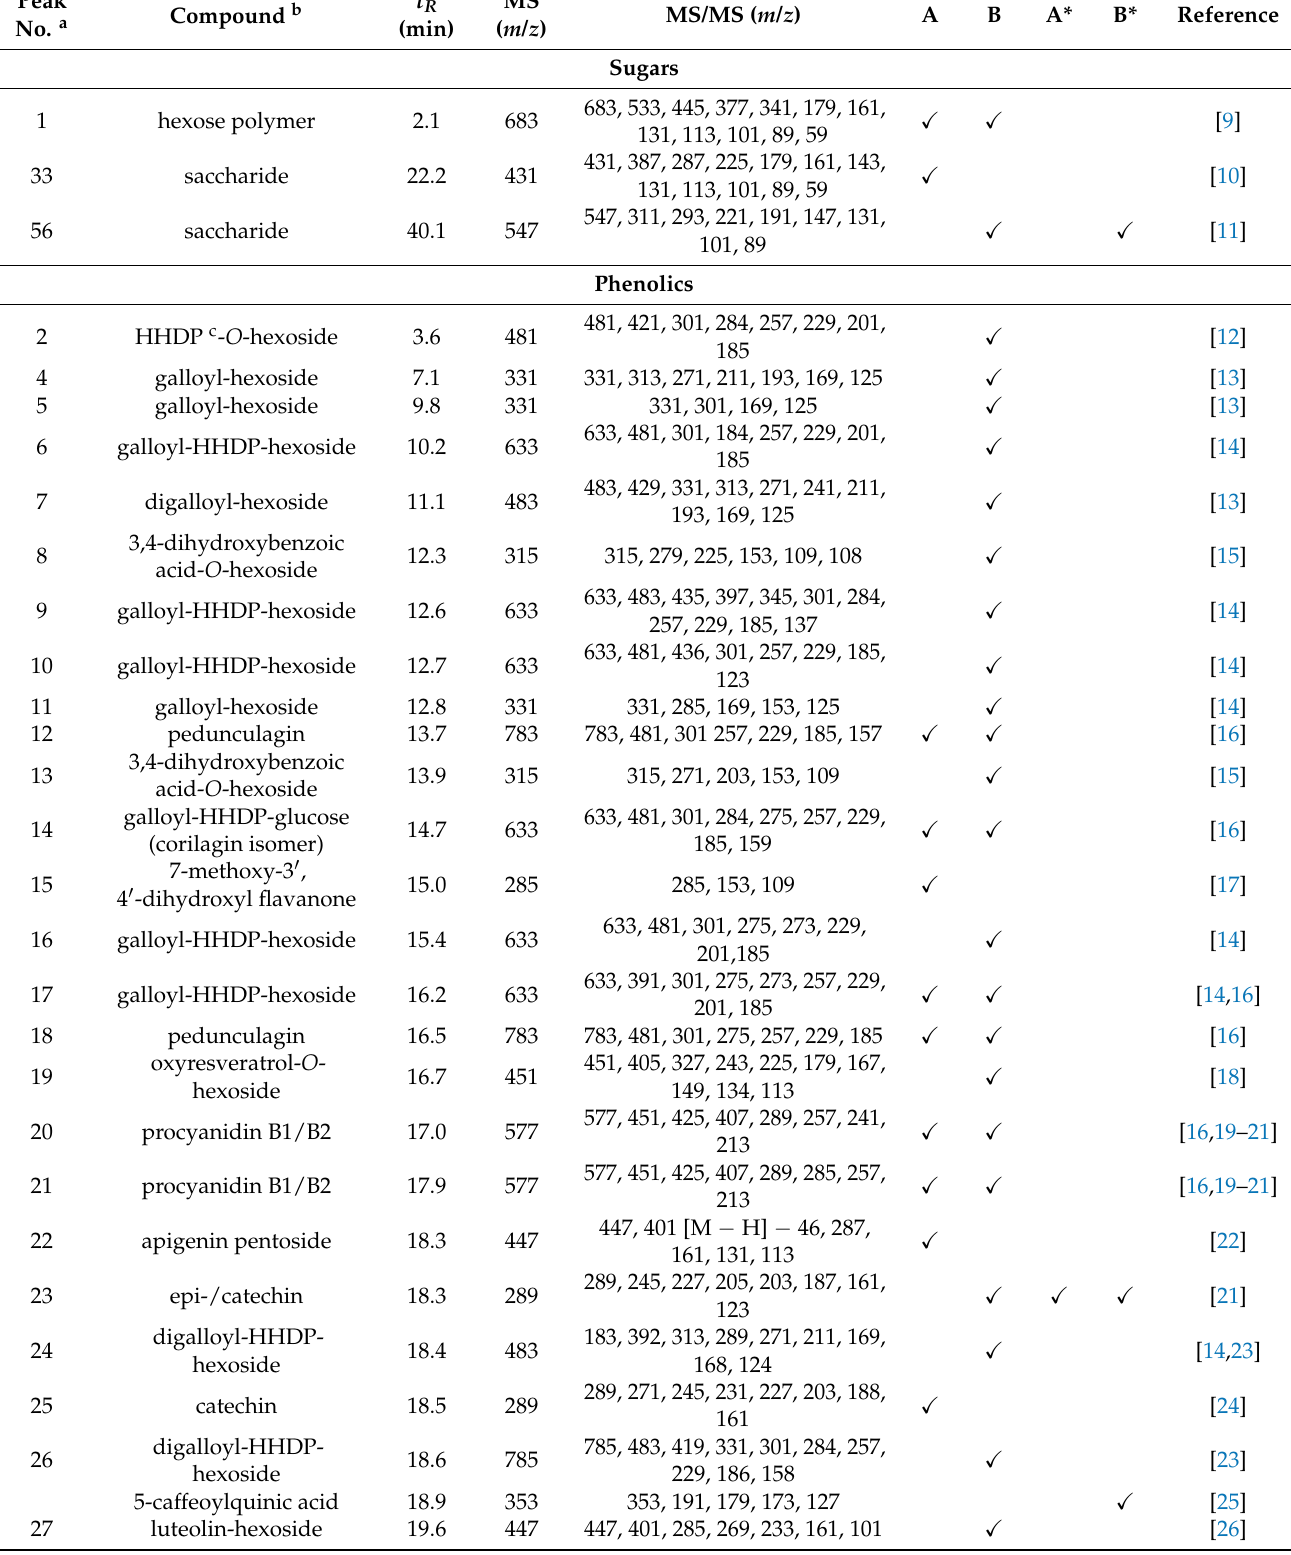
Table 1. Peak assignment of metabolites detected in MeOH extracts of Geum urbanum (A: methanolic extract of defatted seeds; A*: methanolic extract of cold-pressed seed oil) and Geum rivale (B: methanolic extract of defatted seeds; B*: methanolic extract of cold-pressed seed oil) using HPLC-DAD/ESI-MS n (negative ionization mode).